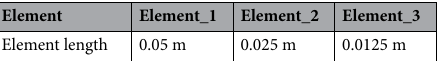
Table 4. Element length.